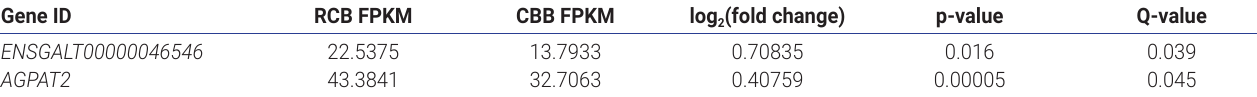
Table 3. Information on lncRNA-46545 and AGPAT2 expression from RNA-seq analysis